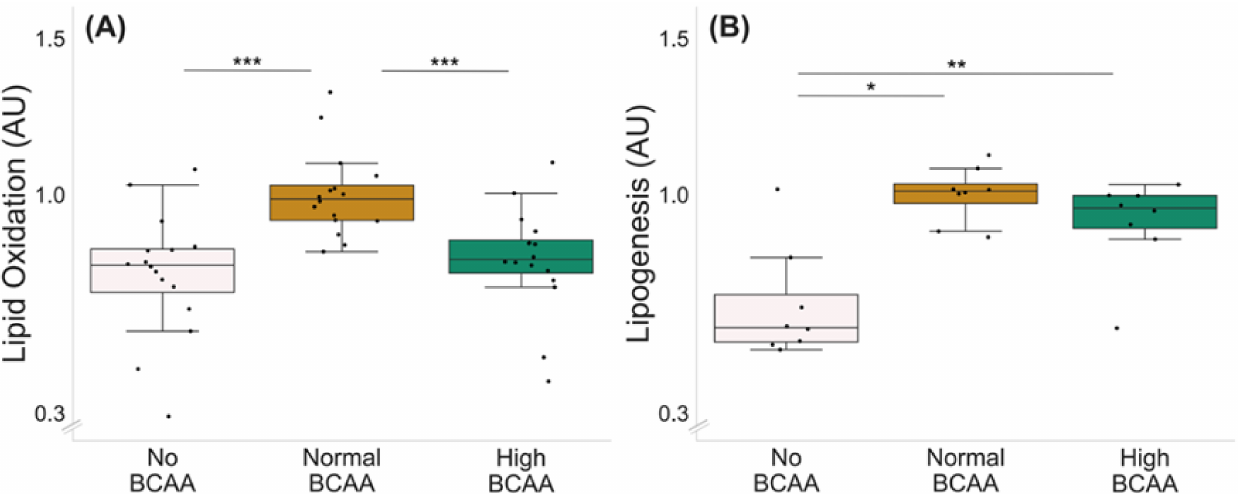
Figure 2. Lipid oxidation ( A ) and lipogenesis ( B ) in C2C12 myotubes with different BCAA lev- els. ( A ) Normal BCAA level (0.8 mmol/L) led to higher lipid oxidation compared with no BCAA (0 mmol/L) or high BCAA (2.8 mmol/L). n = 16/group. ( B ) Normal and high BCAA levels led to higher lipogenesis compared with no BCAA. n = 8/group. Boxes in the boxplot figures depict interquartile ranges and medians, and whiskers represent the 95% confidence interval. * p ≤ 0.050, ** p ≤ 0.010, *** p ≤ 0.001. BCAA = branched-chain amino acid.